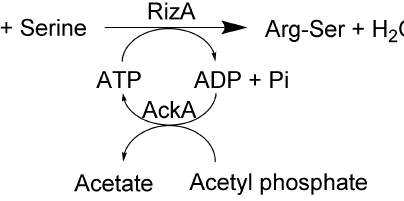
Figure 1. Reaction scheme for the RizA/AckA system for regeneration of ATP from acetyl phosphate for synthesis of Arg-Ser from argine and serine.